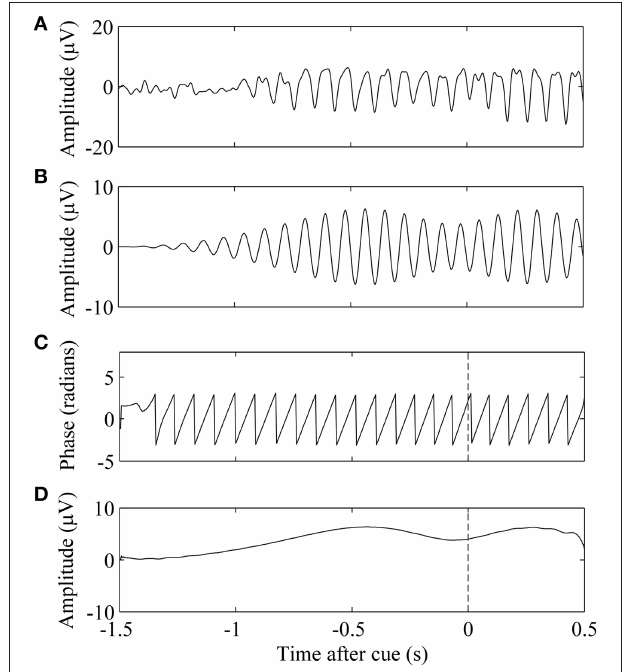
FIGURE 1 | Phase and amplitude extraction of a single EEG trial. (A) Trial n of EEG data. (B) Signal was filtered in the subject-specific mu band. (C) The phase of the band-limited signal at τ n , the time of cue presentation, is marked by the vertical dashed line. (D) Amplitude of the band-limited